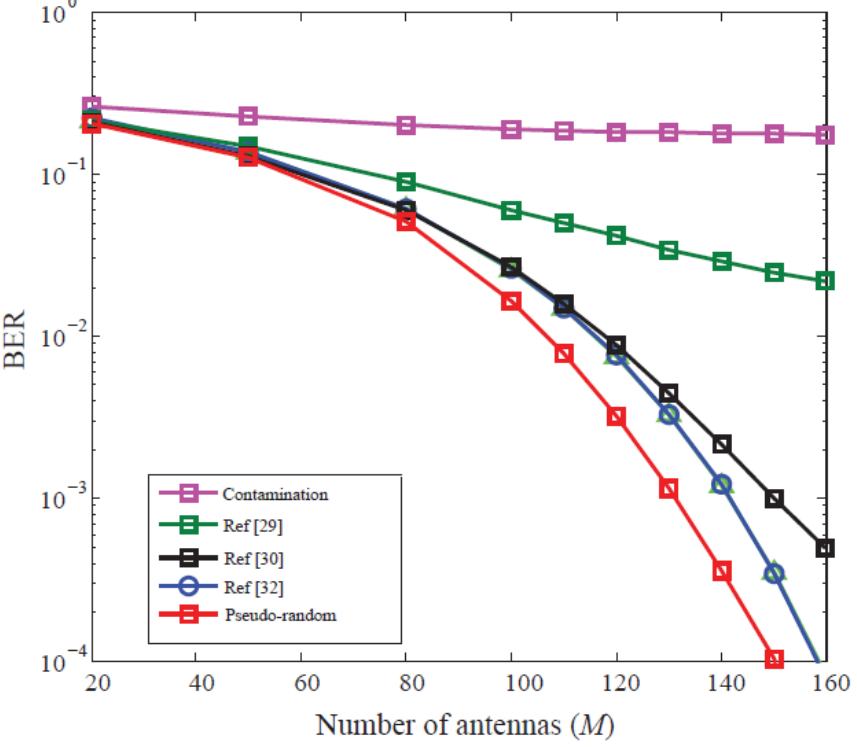
Figure 20. Comparison of the BER of the proposed pseudo-random pilot design scheme with other schemes against the number of BS antennas. schemes against the number of BS